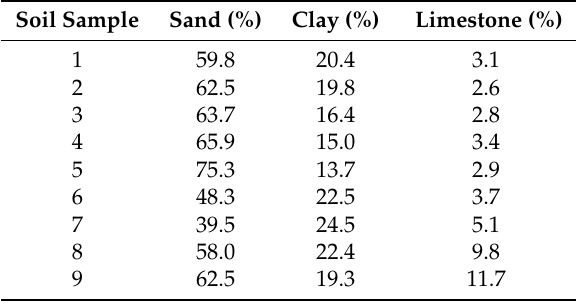
Figure A1. The two-dimensional principal subspace for the different textural soil percentages (correlation matrix PCA). Table A1. Different compositional soils.